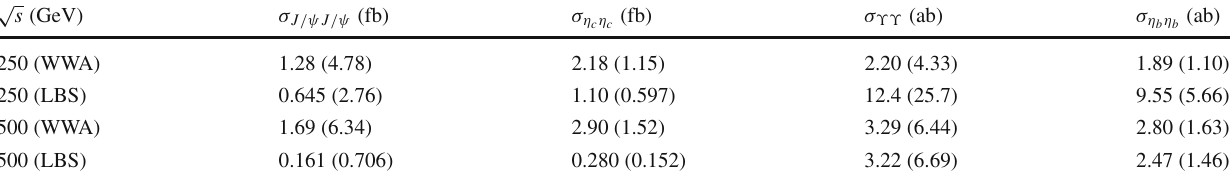
Table 2 The LO (in brackets) and NLO total cross sections for quarkonium pair production via photon–photon fusion at future e + e − colliders. The renormalization scale μ